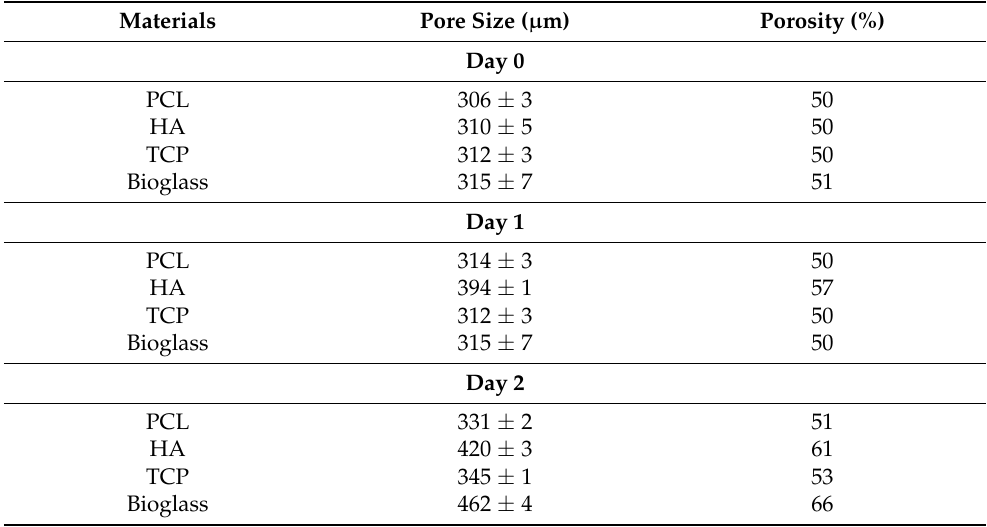
Table 3. Pore size and porosity values of scaffolds (300 µ m pore size) before and after the degradation